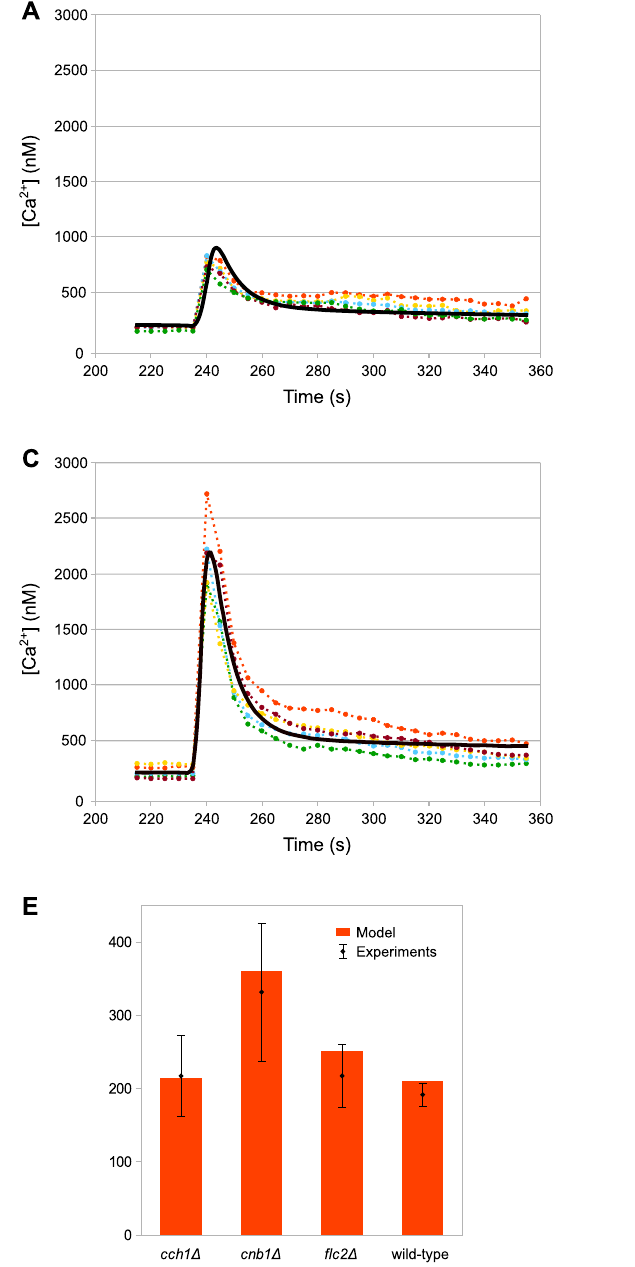
FIGURE 3 | Comparison of simulation outcomes and experimental measurements. In Figures (A – D) the dotted lines represent experimental measurements and different colours indicate replicates, while the black lines represent model simulations. (A) Wild-type. (B) cnb1 Δ . (C) cch1 Δ . (D) fl c2 Δ . (E) Baseline cytosolic Ca 2+ concentration (nM). (F) Max peak cytosolic Ca 2+ concentration (nM). HTS wasapplied to the cells at 235 s by adding four volumesof distilled water to the medium (E,F) Plots constructed using the same data shown in (A – D) ; bars represent standard